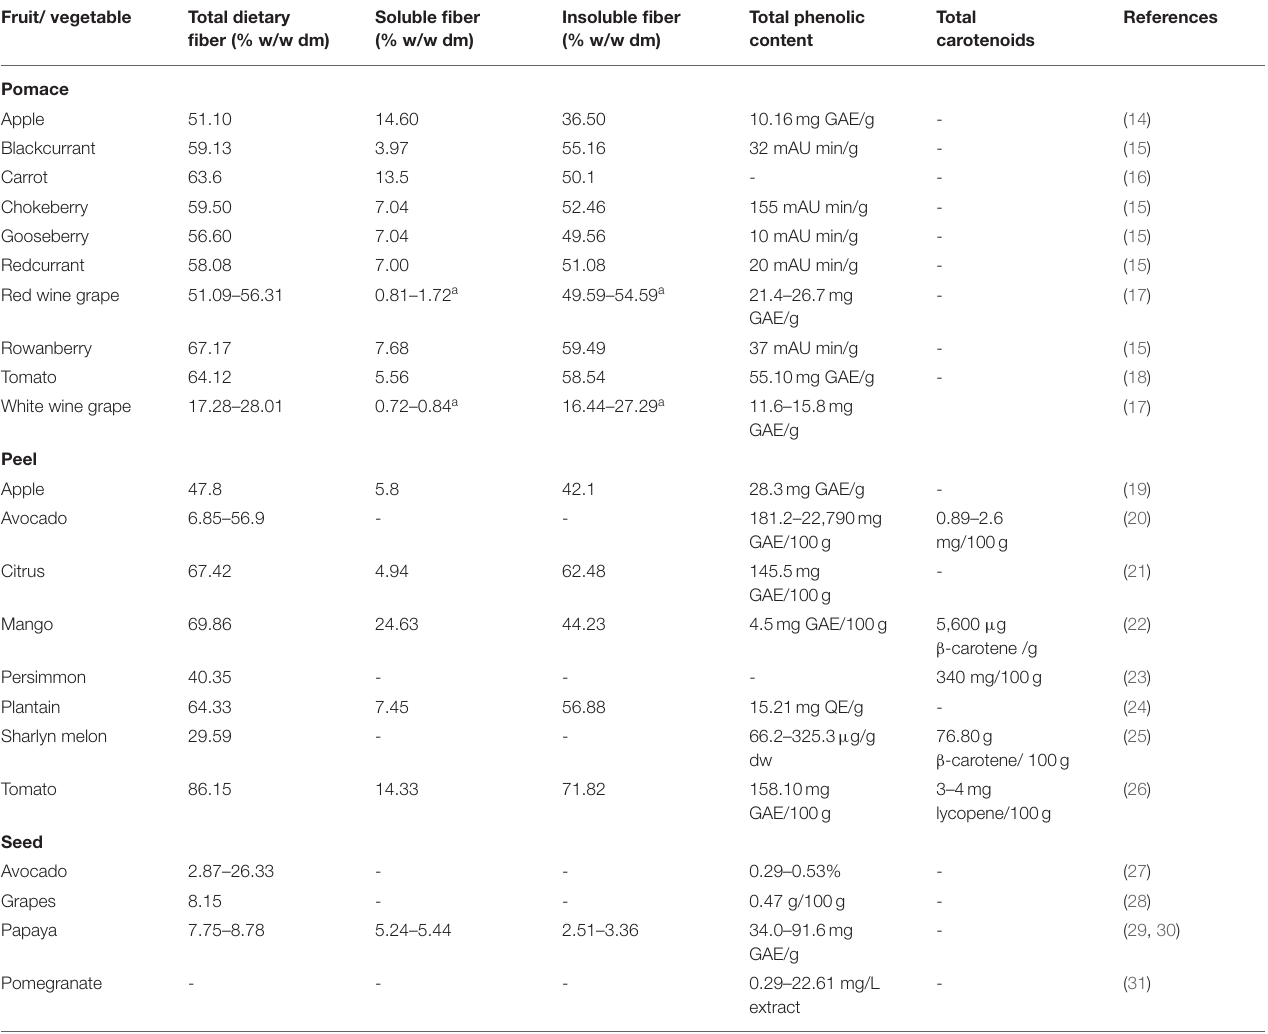
TABLE 1 | Dietary fiber and bioactive compounds of the main fruit and vegetables by-products. Fruit/